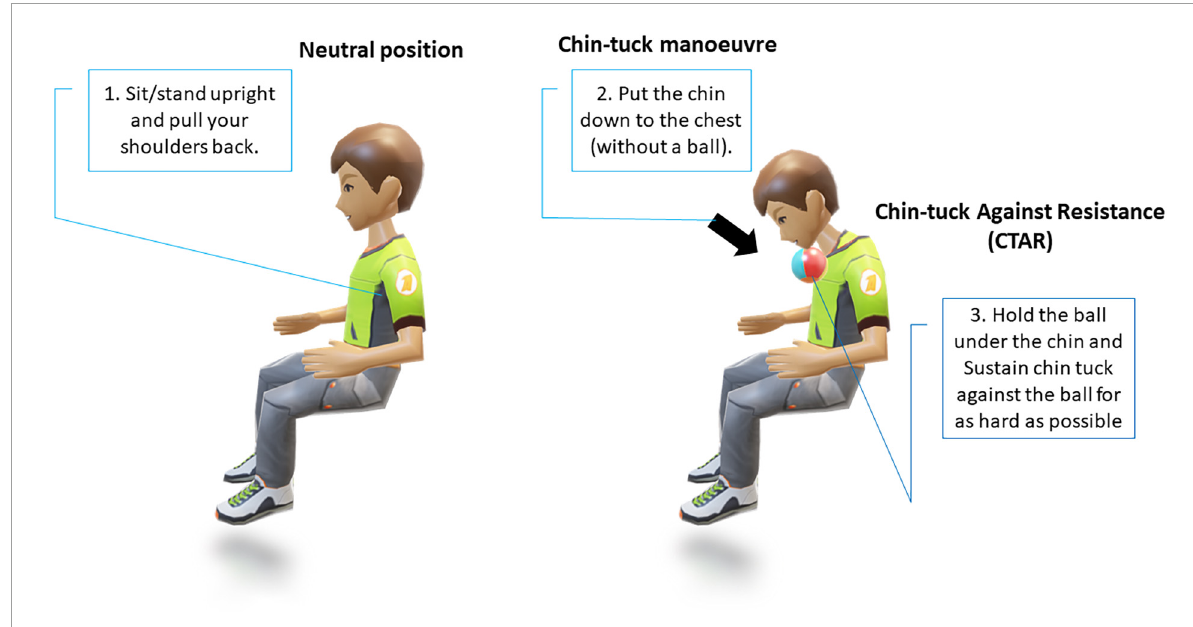
FIGURE4 Procedure of chin-tuck maneuver and chin-tuck against